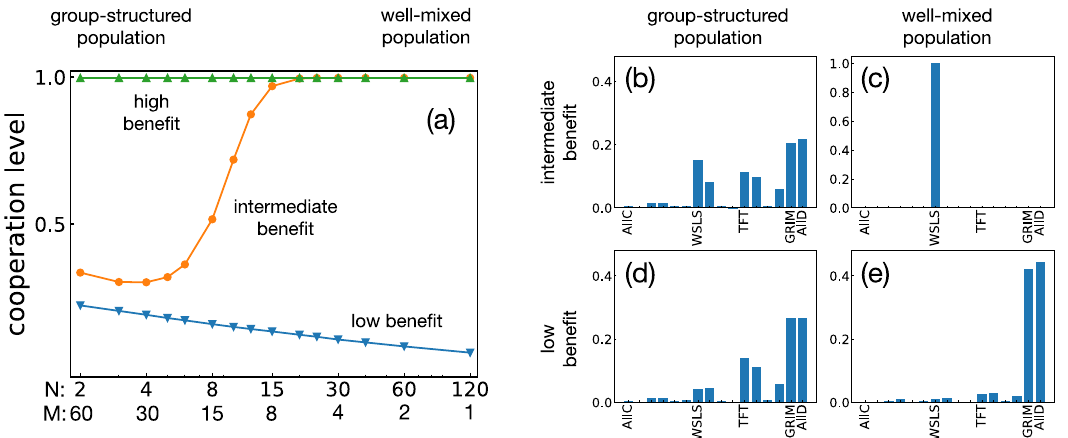
Figure 3. The effect of group structure on the evolution of cooperation. Here we keep the total population size fixed to MN = 120 , while simultaneously varying the size N of each group and the number of groups M = 120 / N . ( a ) We observe that group structure has a positive effect for low benefit ( b = 1.5 ), a negative effect for intermediate benefit ( b = 3 ) and no effect for high benefit ( b = 6 ). ( b – e ) To explore these non-trivial effects of group structure in more detail, we record the abundance of each strategy for four different scenarios. The scenarios differ in whether the benefit is low or intermediate ( b = 1.5 and b = 3 , respectively), and whether the population is group-structured or well-mixed ( N = 2 , M = 60 and N = 120 , M = 1 , respectively). Note that the different panels use different scales for the vertical